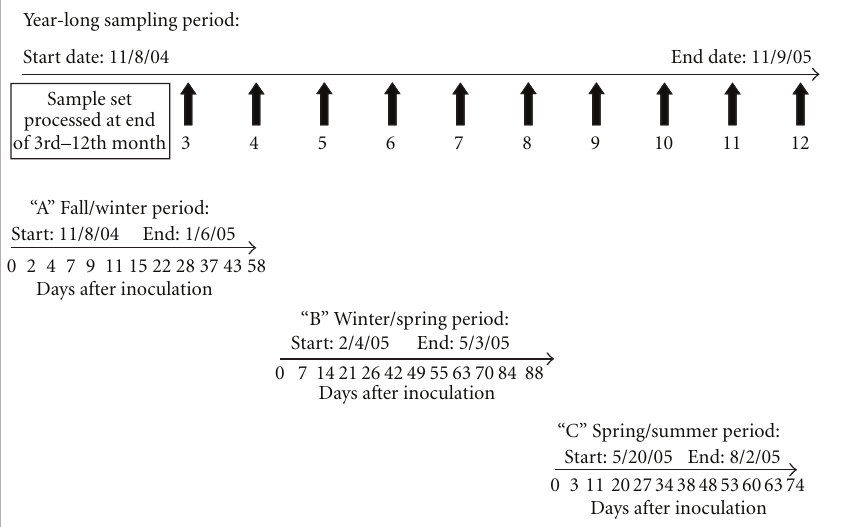
locked door was built into one side of the enclosure with a minimum clearance with the concrete slab and